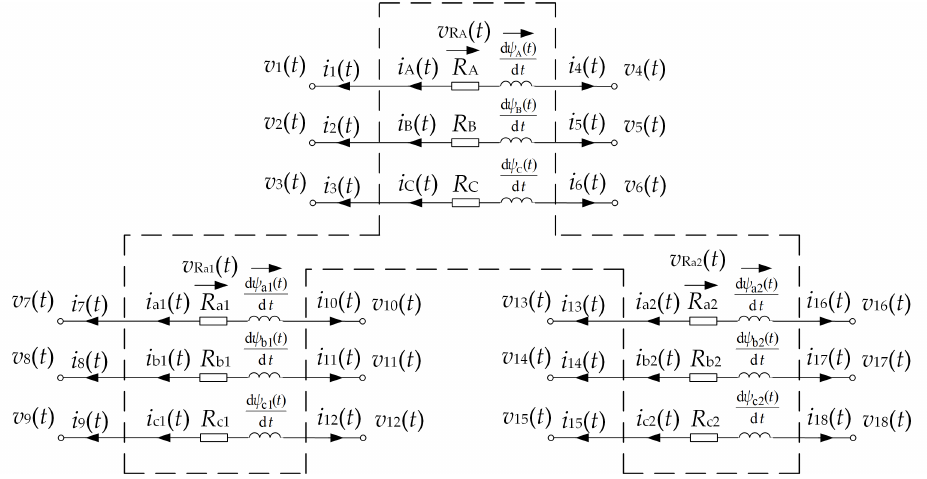
Figure 14. A diagram of a three-winding, three-phase transformer as an eighteen-pole device. The three-winding, three-phase transformer consists of a three-column ferromagnetic core; on each column, there is placed one upper voltage winding (phase indexes A, B, C) and two lower voltage windings (phase indexes: a1, b1, c1 and a2, b2, c2, respectively). When creating the mathematical model of the transformer, the losses in the core, nonlinear magnetization characteristics and losses in structural elements were all taken into